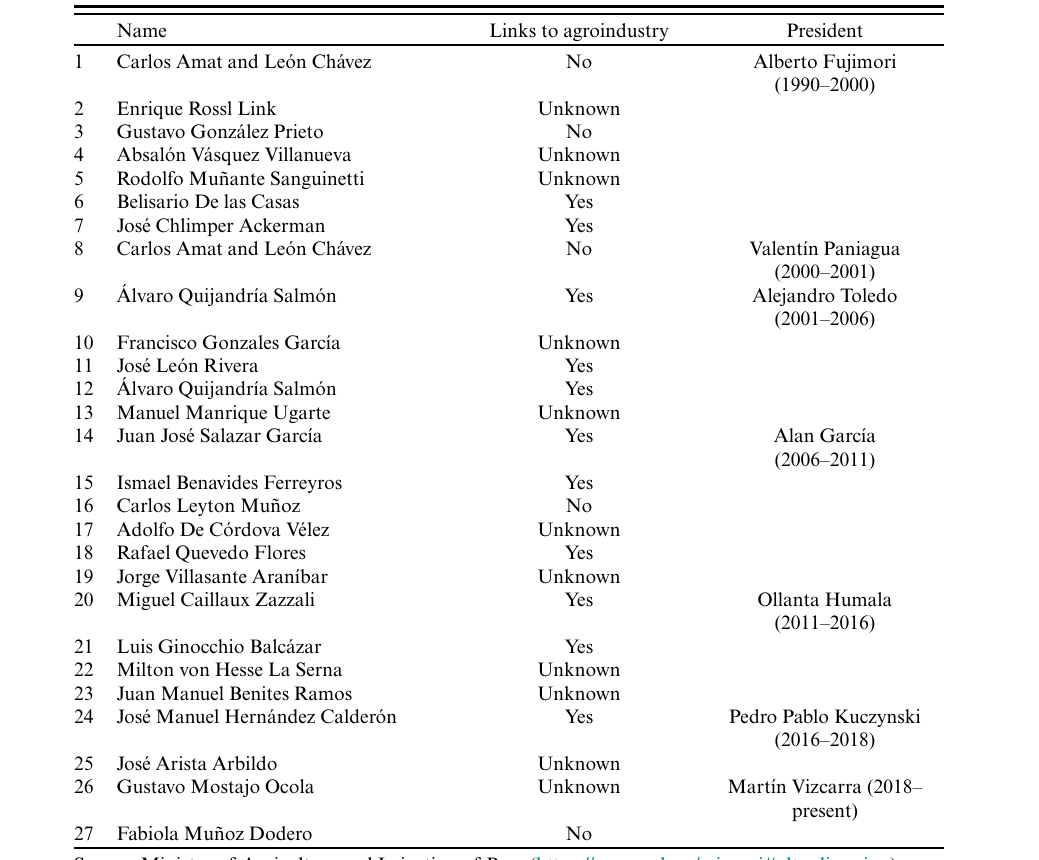
Table 1 . Relationship between Ministers of Agriculture and Irrigation and agroindustry (1990–